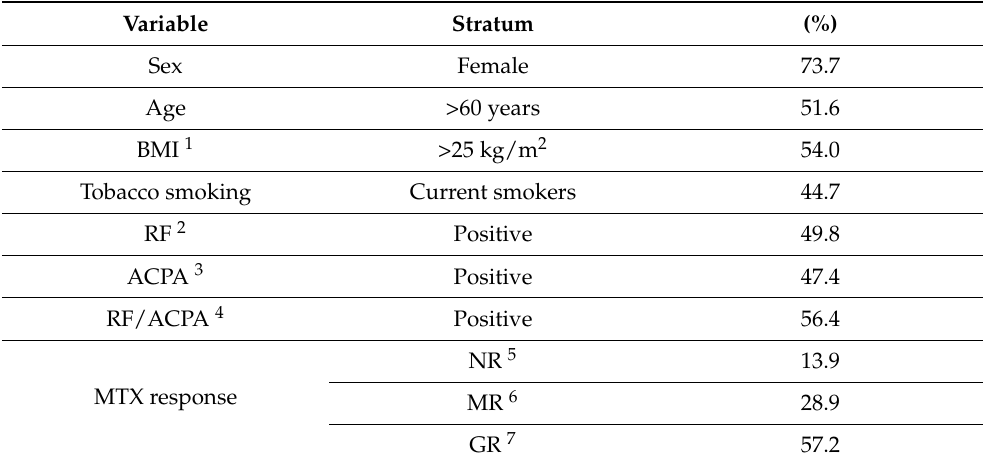
Table 2. Characteristics of the patients included in the study ( n = 273).